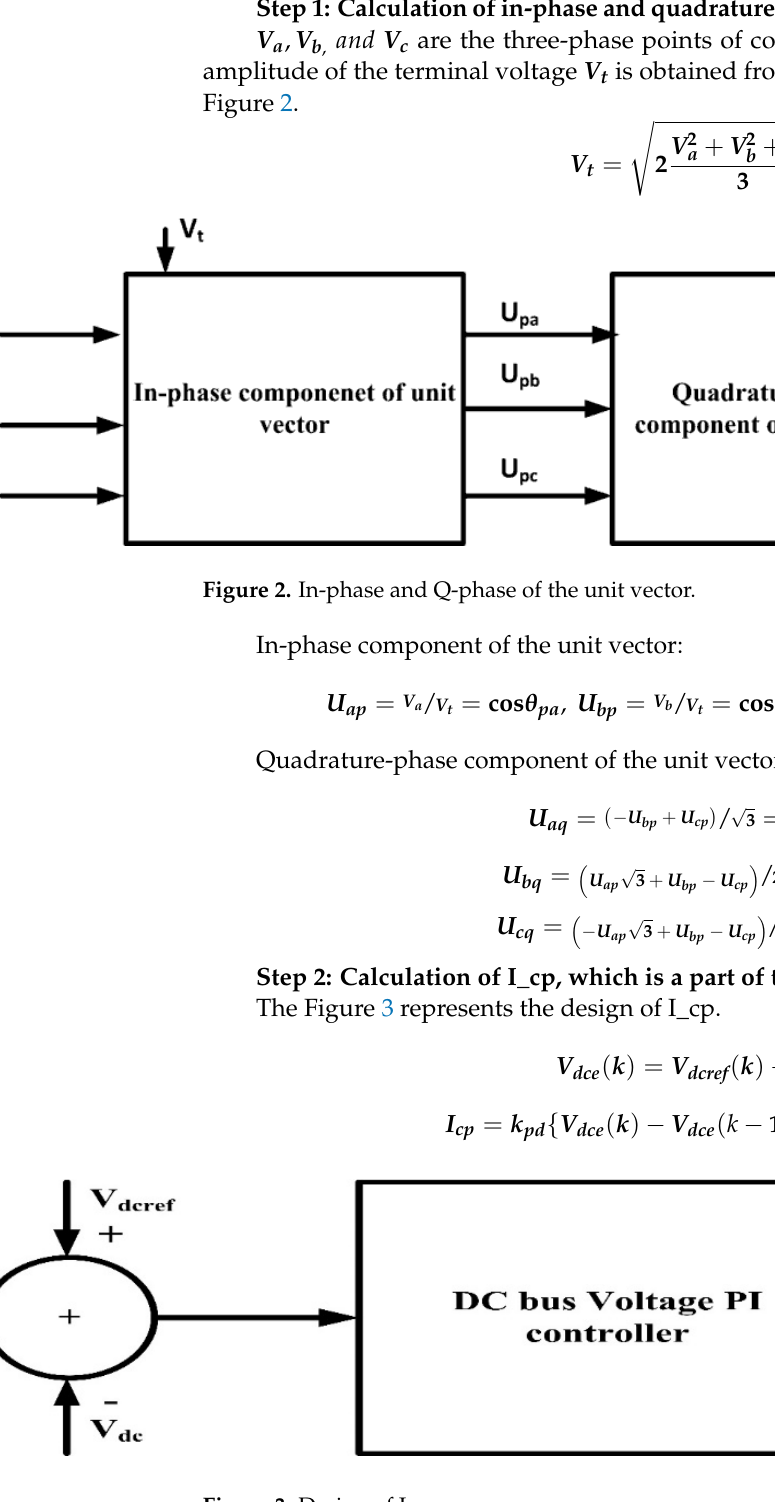
Figure 4. Design of I_cq.